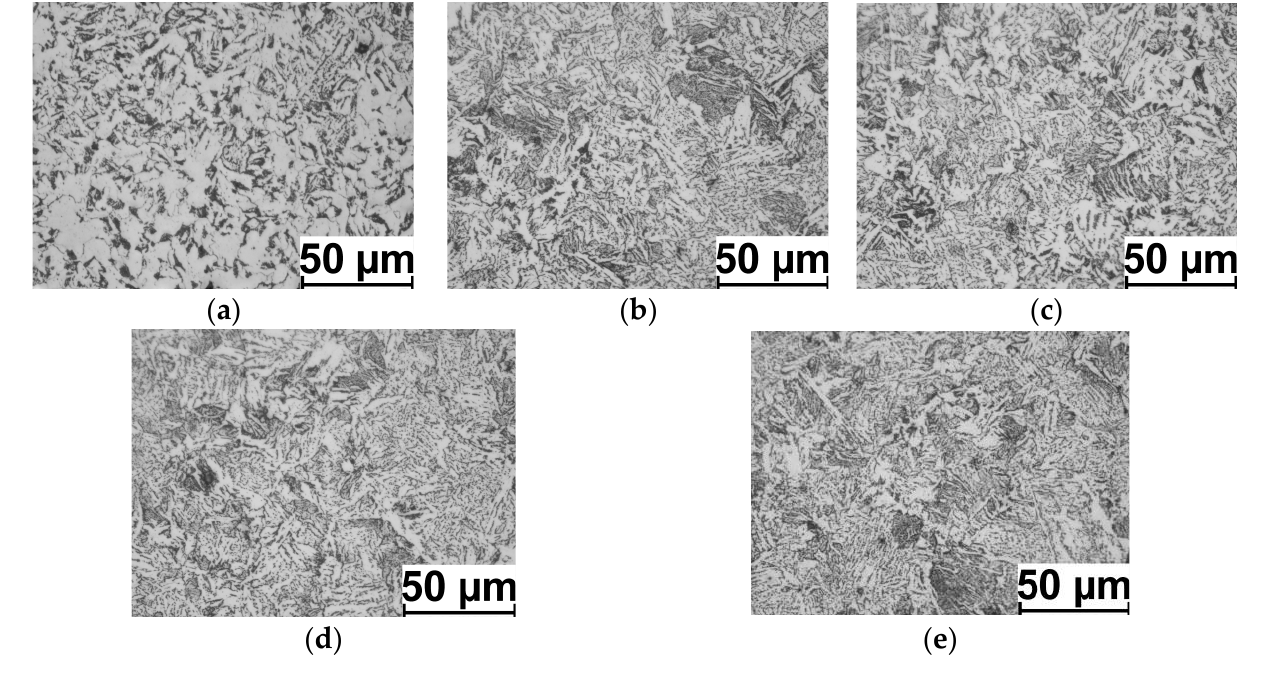
Figure 15. Example microstructures of 20MnB4 steel after physical modelling of the wire rod rolling process for test variant V3 (marking of points in accordance with Figure 5): ( a ) point P. 1, ( b ) point P. 1 ‐ 2, ( c ) point P. 1 ‐ 3, ( d ) point P. 1 ‐ 4, and ( e ) point P. 1 ‐ 5. Table 6. Results of measurements of ferrite grain size and hardness of 20MnB4 steel after physical modelling of the rolling process of a 5.5 mm diameter wire